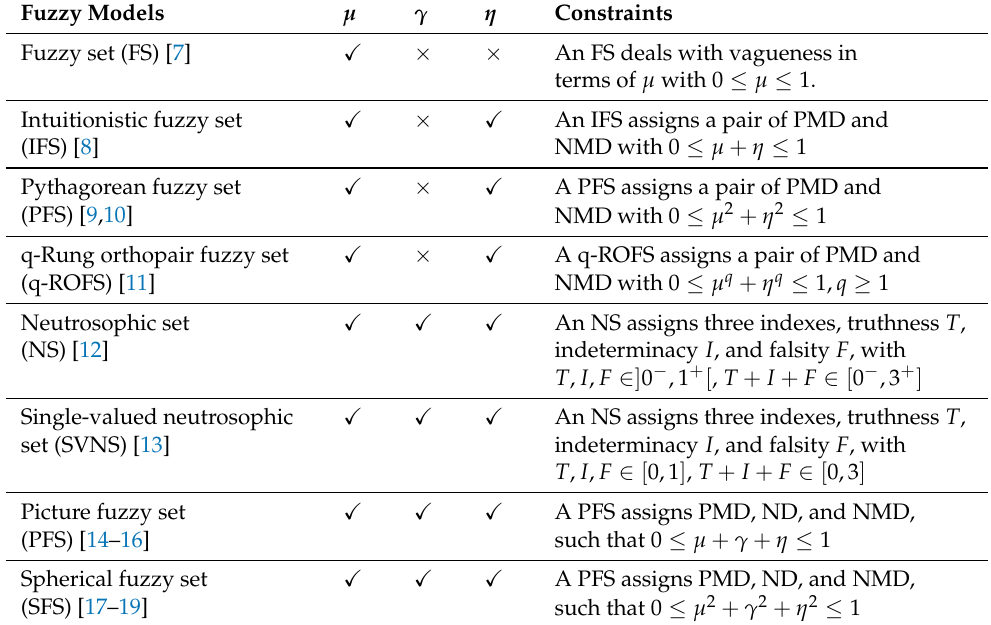
Table 1. Some fuzzy models with existing